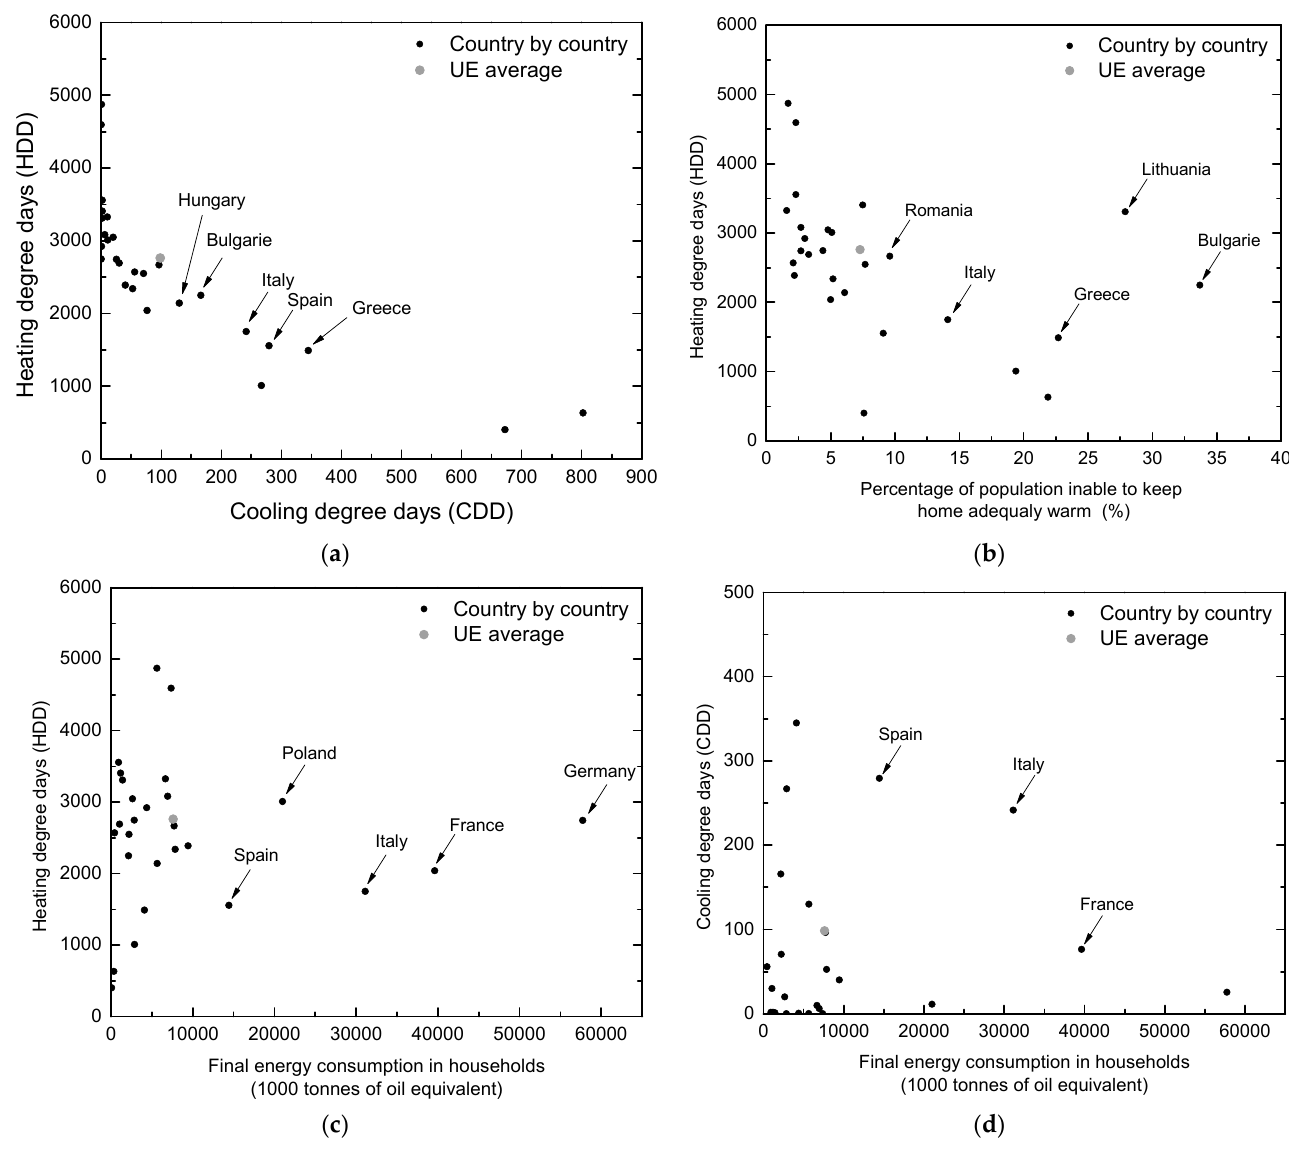
Figure 4. Climate data and building energy performance: ( a ) HDD vs. CDD; ( b ) HDD vs. energy poverty; ( c ) HDD vs. building energy consumption; and ( d ) CDD vs. building energy consumption (Sources: EU Buildings Factsheets).